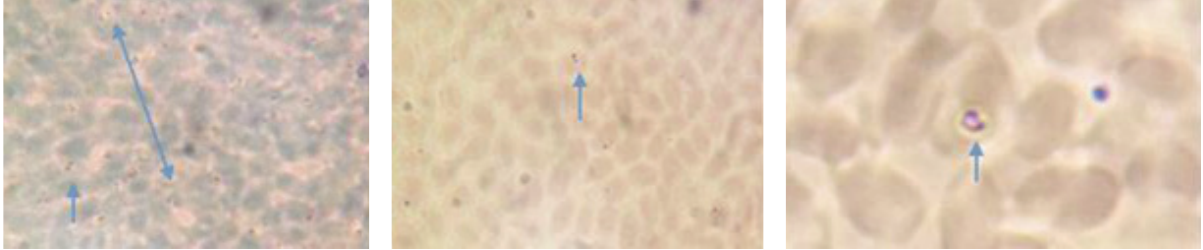
Figure 2: Piroplasms with different shapes (arrows) in Giemsa’s stained blood.